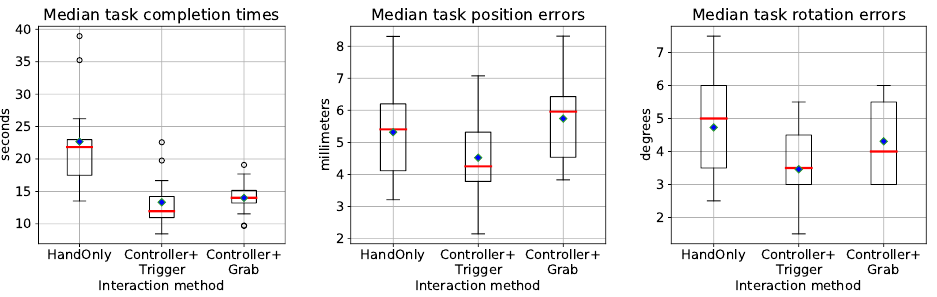
Figure 4. The task completion times ( left ), the object position errors between the start and target positions ( middle ) and the object rotation errors between the start and target orientations ( right ). For each participant, we computed the median values over six tasks. The median values over all participants are drawn as red lines and the mean values as blue